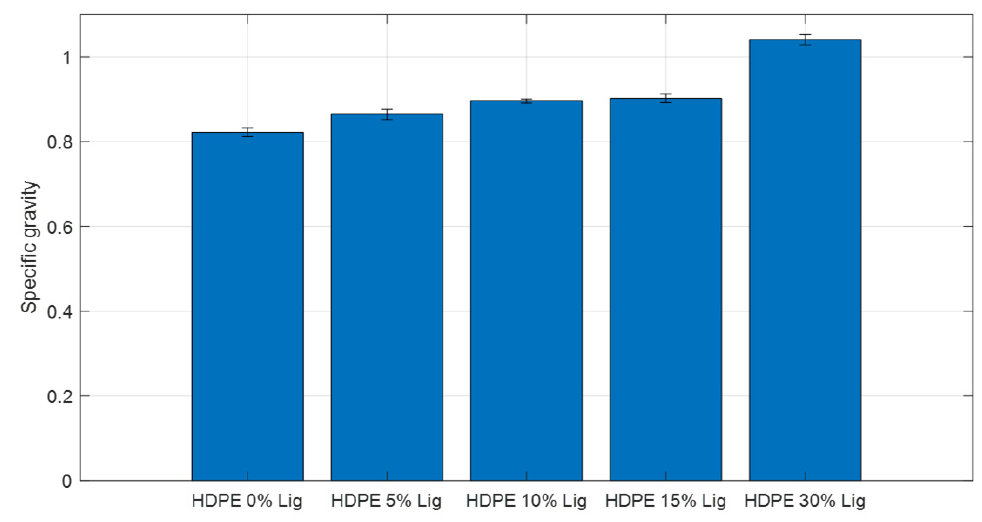
Figure 9. Specific gravity comparison for HDPE–lignin blend compositions.